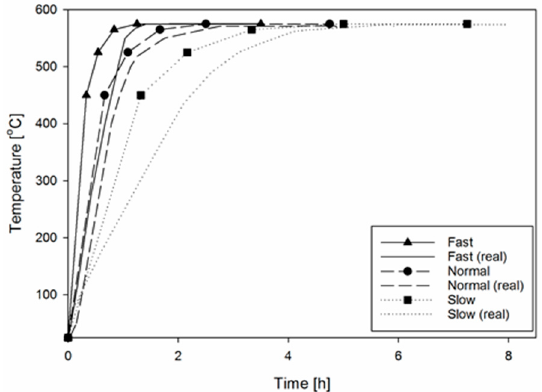
Figure 11. Temperature plots of the intended and the logged (real) homogenization cycles.